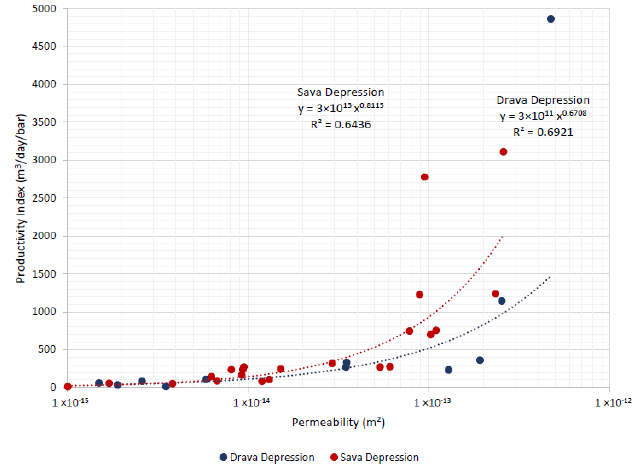
Figure 3. Productivity index vs. permeability data correlation—post-rift phase.